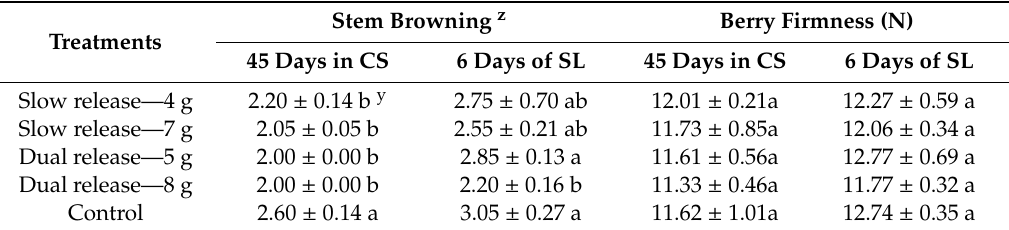
Table 3. Stem browning scores and berry firmness (N) of clamshell-packaged ‘BRS Nubia’ seeded table grapes after 45 days of storage in cold storage (CS) at 1 ± 1 ◦ C followed by 6 days at shelf life (SL) at 22 ± 1 ◦ C, packaged with di ff erent SO 2 -generating pads. Stem Browning z Berry Firmness (N) Treatments 45 Days in CS 6 Days of SL